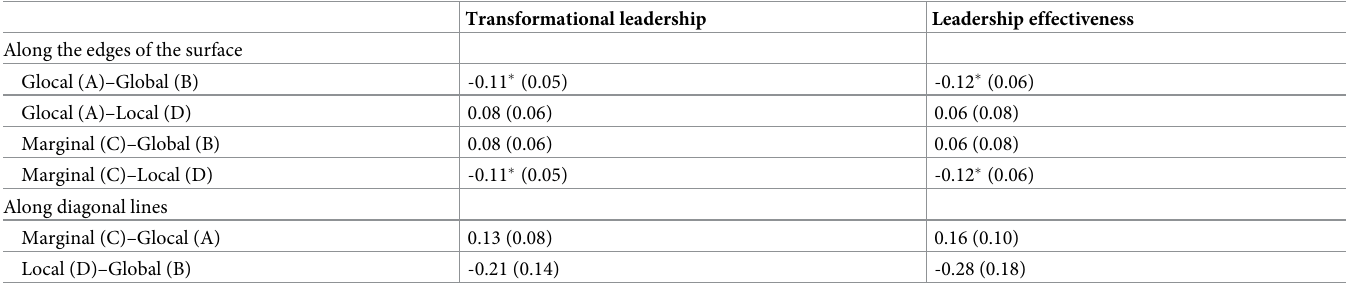
Table 4. Curvatures of all interest